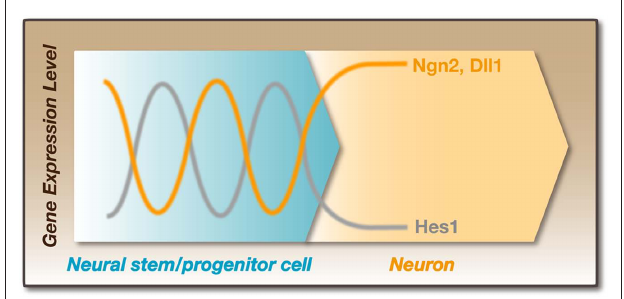
Figure 4 | Dynamic expression in neural stem/progenitor cells. Hes1 expression oscillates with a period of ∼ 2–3 h in neural progenitor cells. In these cells, Ngn2 and Dll1 expression also oscillates. Hes1 protein expression exhibits an inverse correlation with Ngn2 protein and Dll1 mRNA expression. In contrast, the expression of Ngn2 and Dll1 is sustained in post-mitotic neurons, which lose Hes1 expression. It is likely that Dll1 oscillation periodically activates Notch signaling between neighboring cells. This reciprocal regulation is particularly important for the maintenance of neural stem/progenitor cells before the formation of neurons.